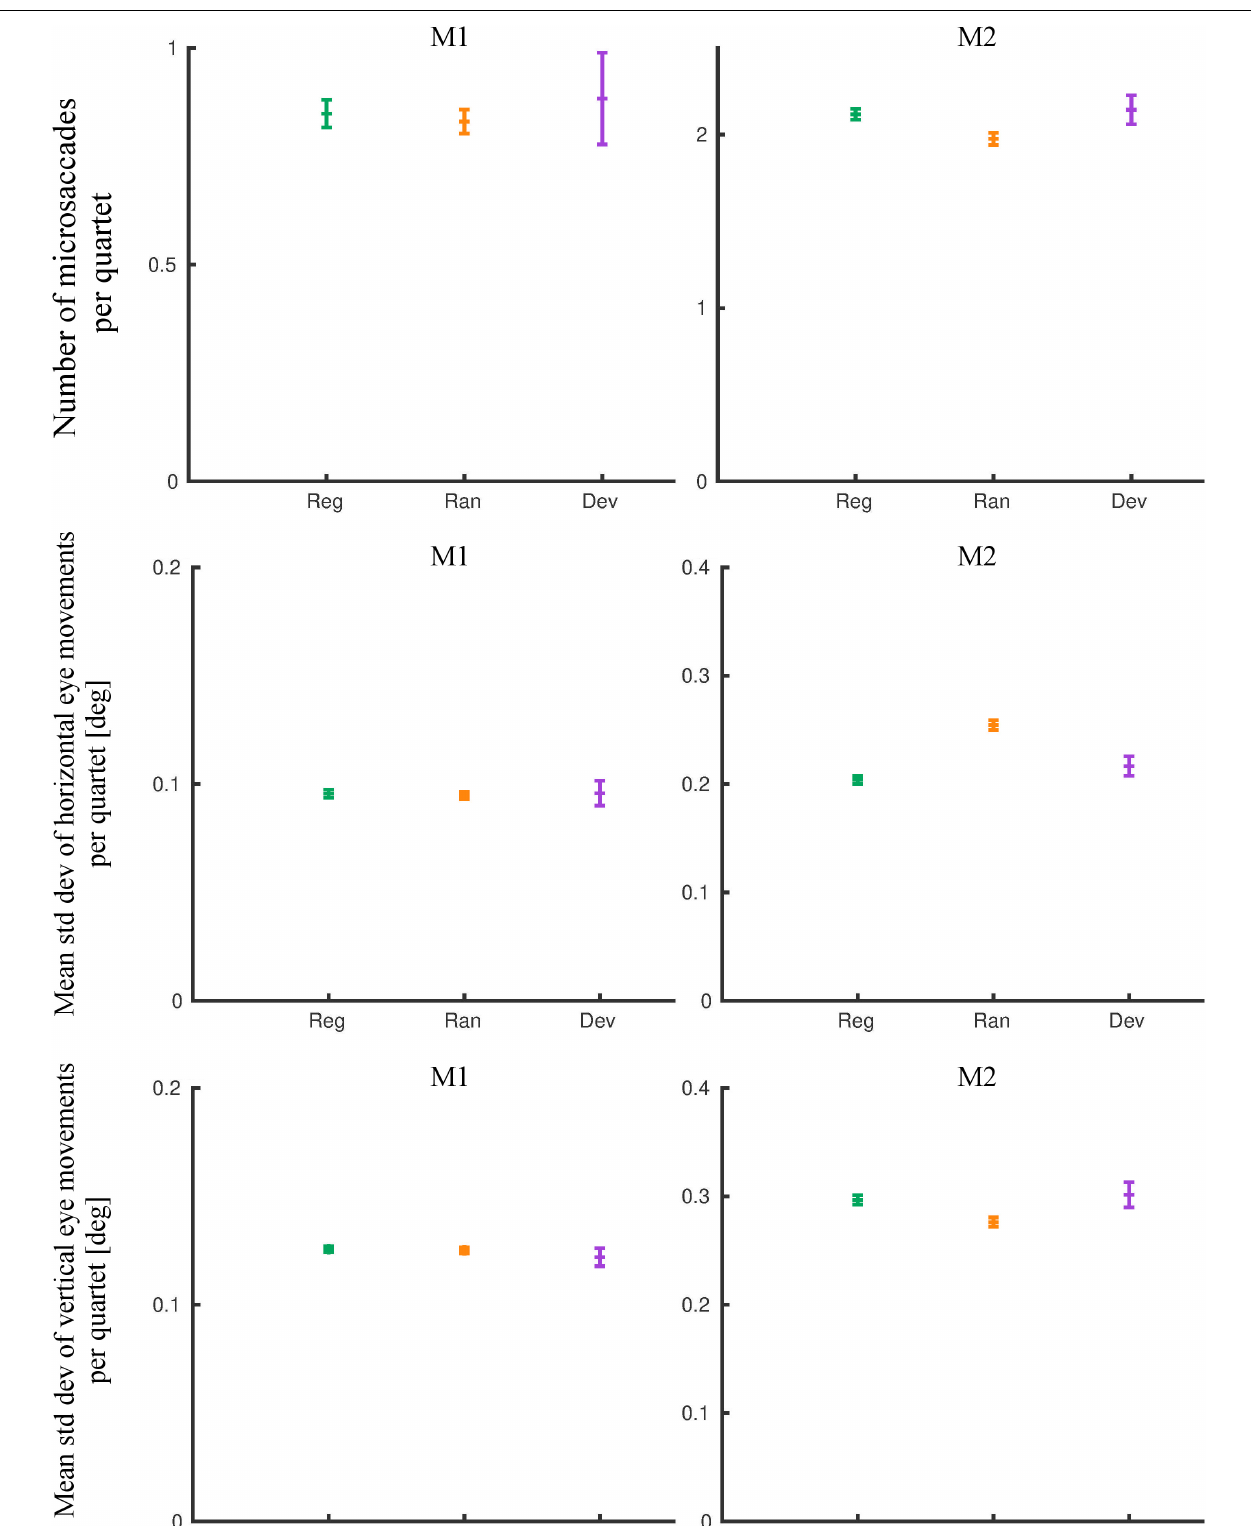
FIGURE 5 | Eye movement metrics of the pre-scanning exposure phase (last eight exposure sessions). The means and 95% confidence intervals for the regular (Reg), random (Ran), and deviant (Dev) quartets are plotted for monkey M1 and M2. Std dev, standard deviation.